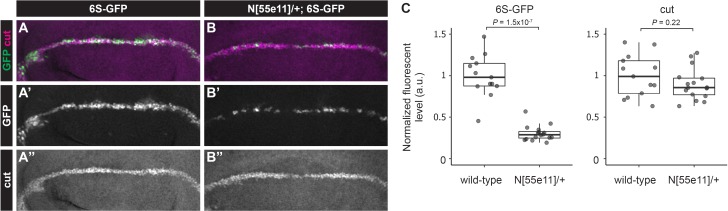
6S-GFP reporter activity is sensitive to Notch gene dose.(A–B”) Representative immunostained third instar wing discs from wild-type or N heterozygous female flies containing 6xSPS-GFP (6S-GFP) stained with cut (magenta). (C) Quantification of GFP and Cut levels from wing discs of indicated genotype. Each dot represents the average wing margin cell pixel intensity as measured from an individual imaginal disc. Two-sided Student’s t-test.